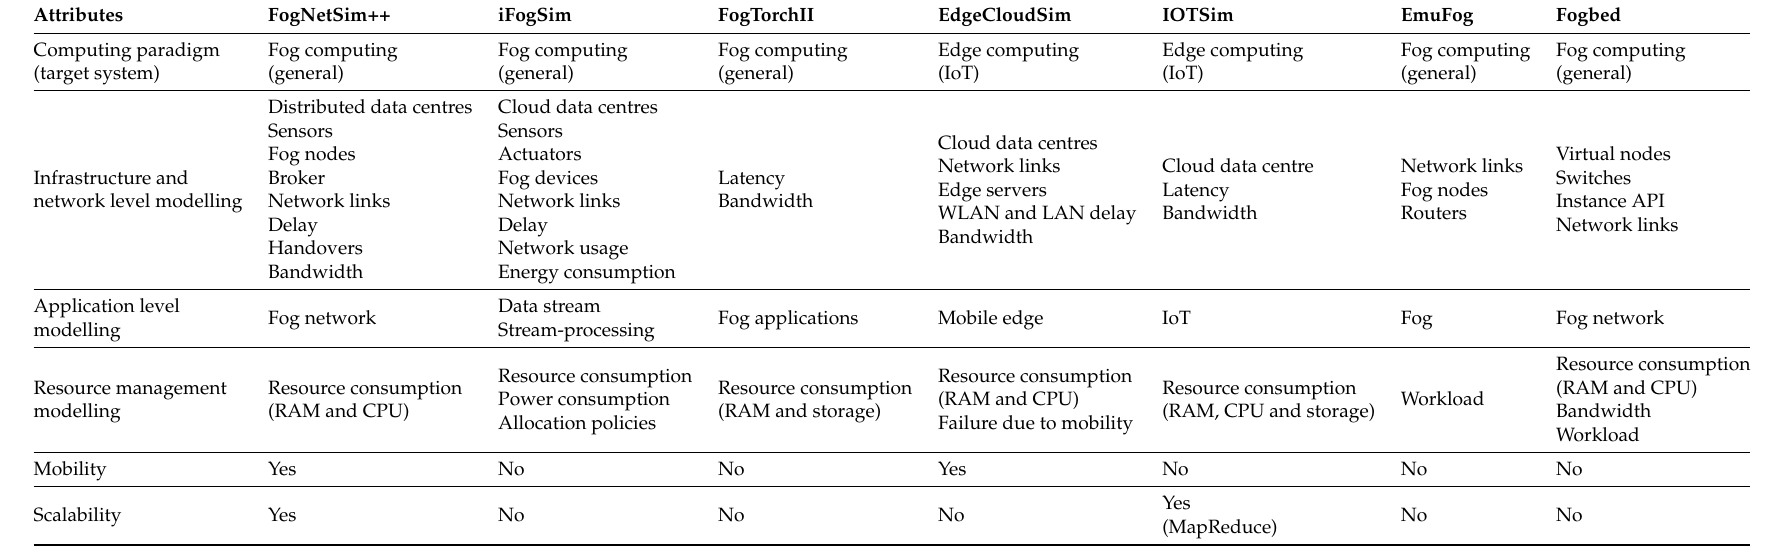
Table 1. Fog and Edge Simulator Tools: Comparative